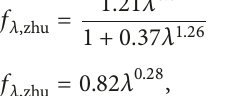
Figure 3: Dynamic mesh force response.